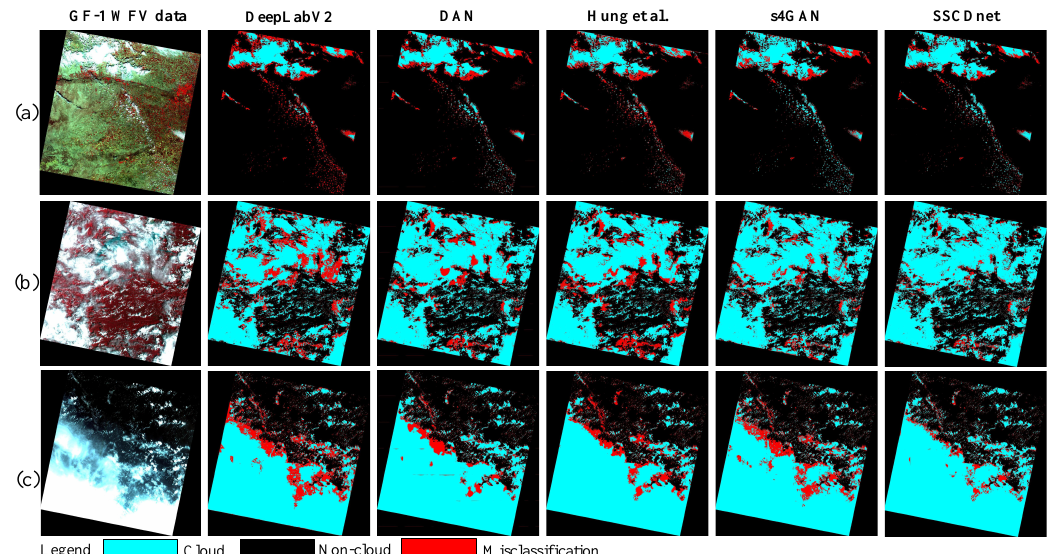
Figure 9. Comparison of cloud detection results of different methods on GF-1 WFV dataset with labeled sample proportion of